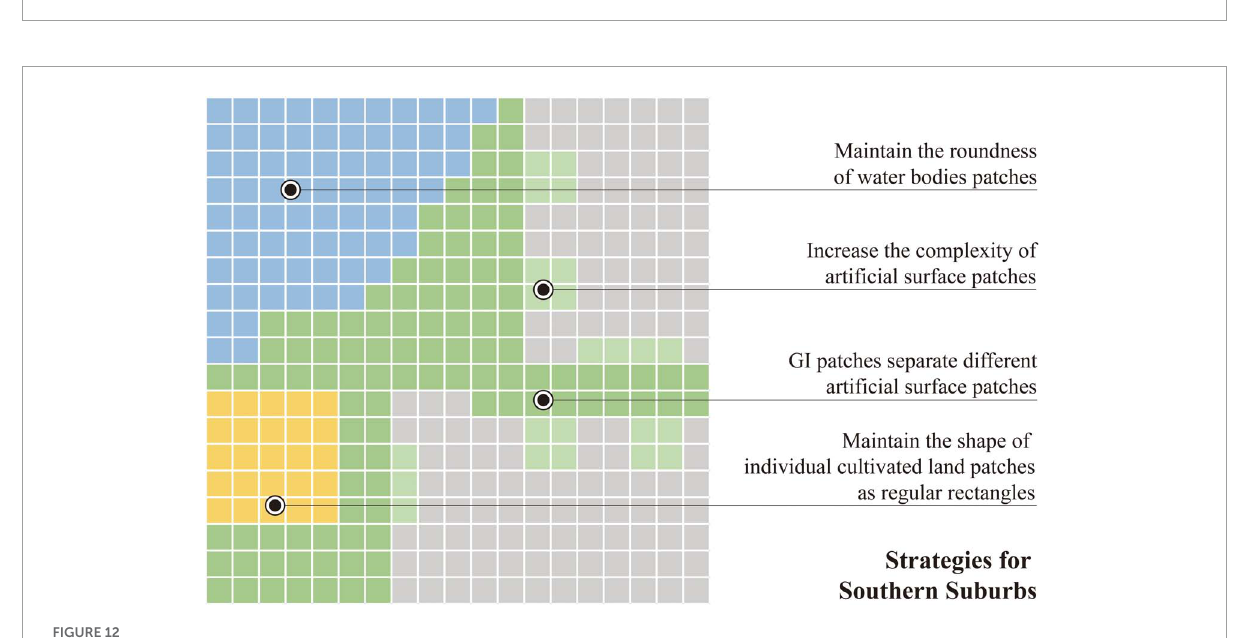
FIGURE11 Strategies for northern suburbs.